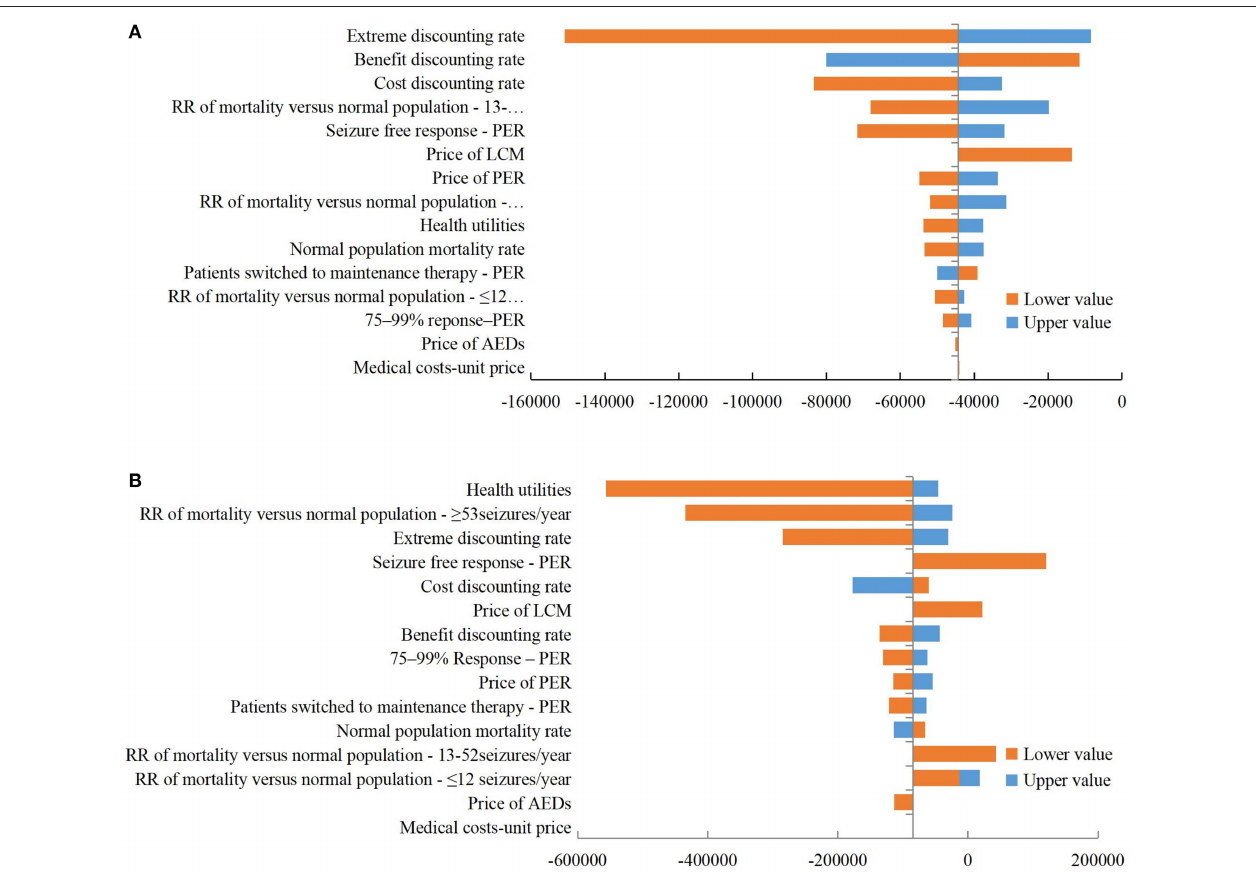
FIGURE 3 | Tornado diagram of deterministic sensitivity analysis. (A) PER 8 mg/day vs. LCM 400 mg/day; (B) PER 4 mg/day vs. LCM 200 mg/day. ER, perampanel; LCM, lacosamide; RR, relative risk; AED, antiepileptic drug.